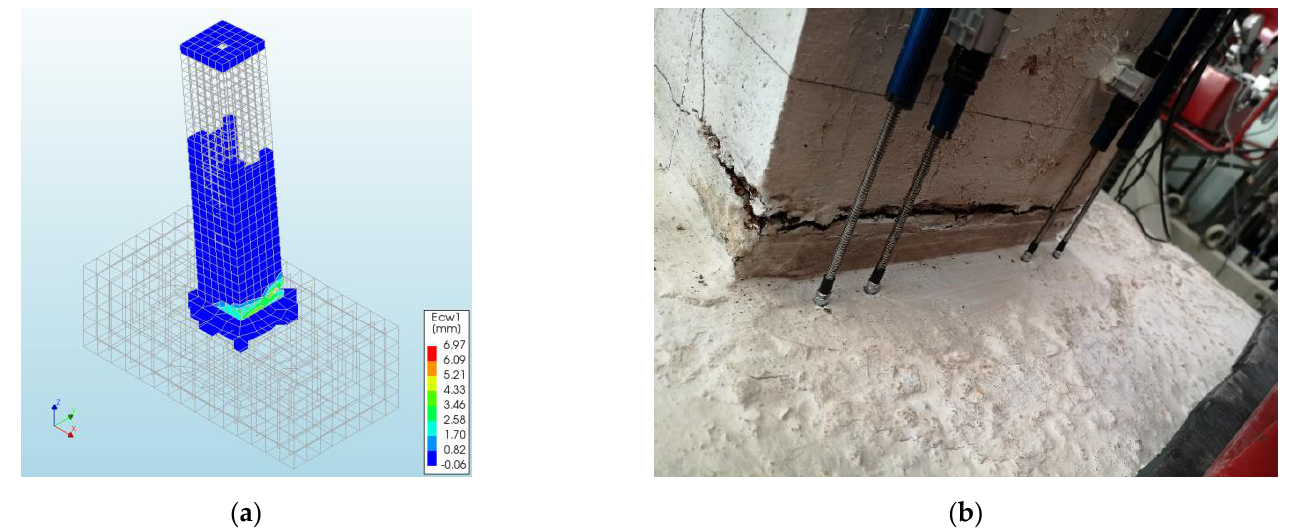
Figure 17. Comparison between cracking pattern, numerical vs. experimental, column B25, drift = − 1.5%. ( a ) Numerical, ( b ) Experimental.